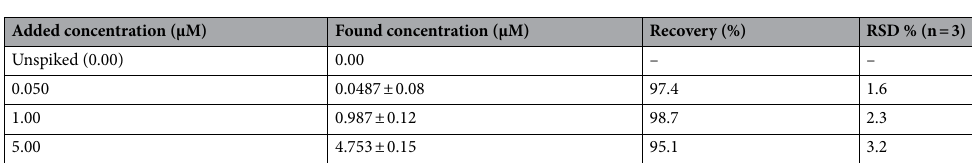
Table 2. Detection of Hg 2+ in water sample using KgM-AgNPs probe. Recovery = (C s − C us )/C st × 100%, C s is the concentration of spiked sample, C us is the concentration of unspiked sample, C st is the concentration of standard